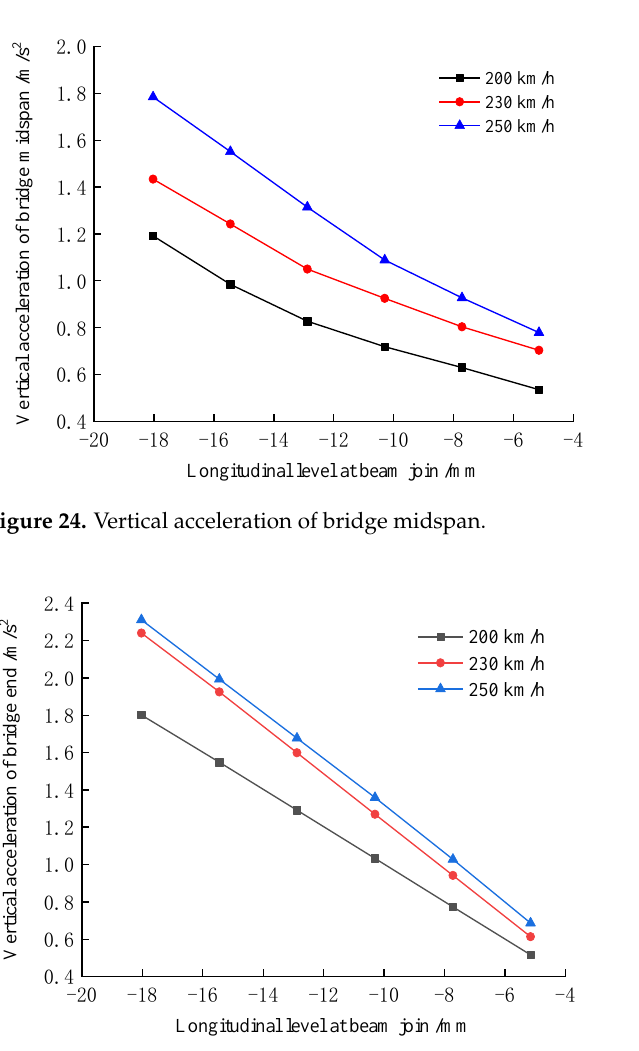
Figure 23. Displacement of bridge midspan.